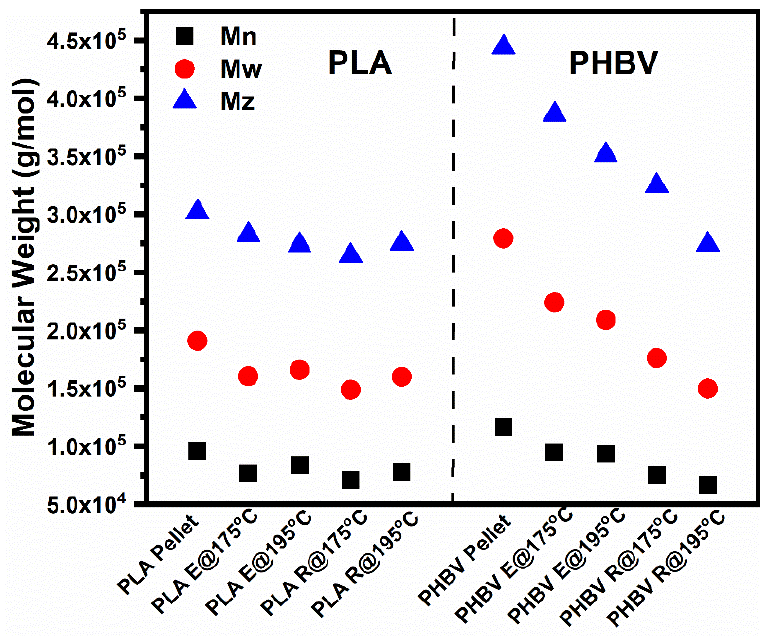
Figure 5. Scatter plots of three molecular weights of PLA, PHBV, and their blends. Table 4. Molecular weights and loss rates of pure PLA and PHBV after processing at various temperatures.